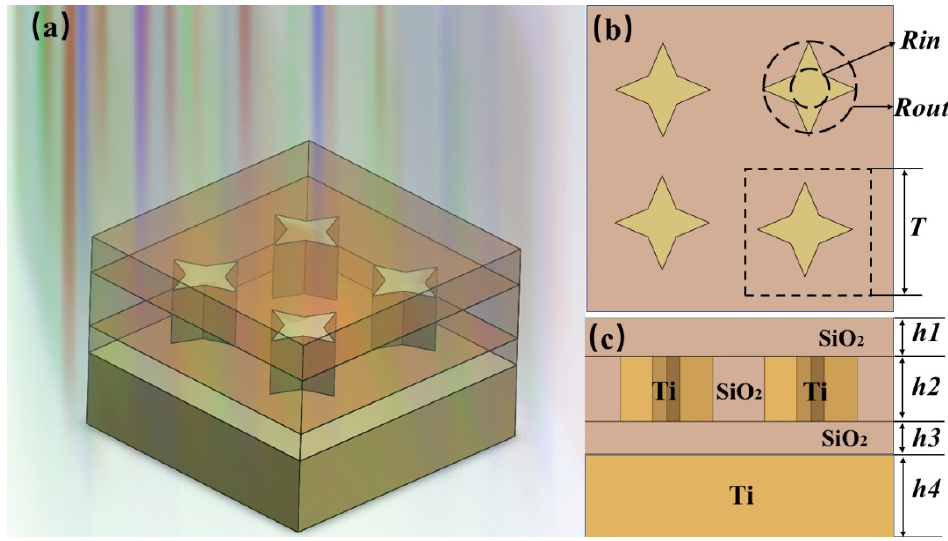
Figure 1. Schematic of the proposed nanostructure. ( a ) Three-dimensional diagram; ( b ) The X–Y plane graph; ( c ) The X-Z plane graph.